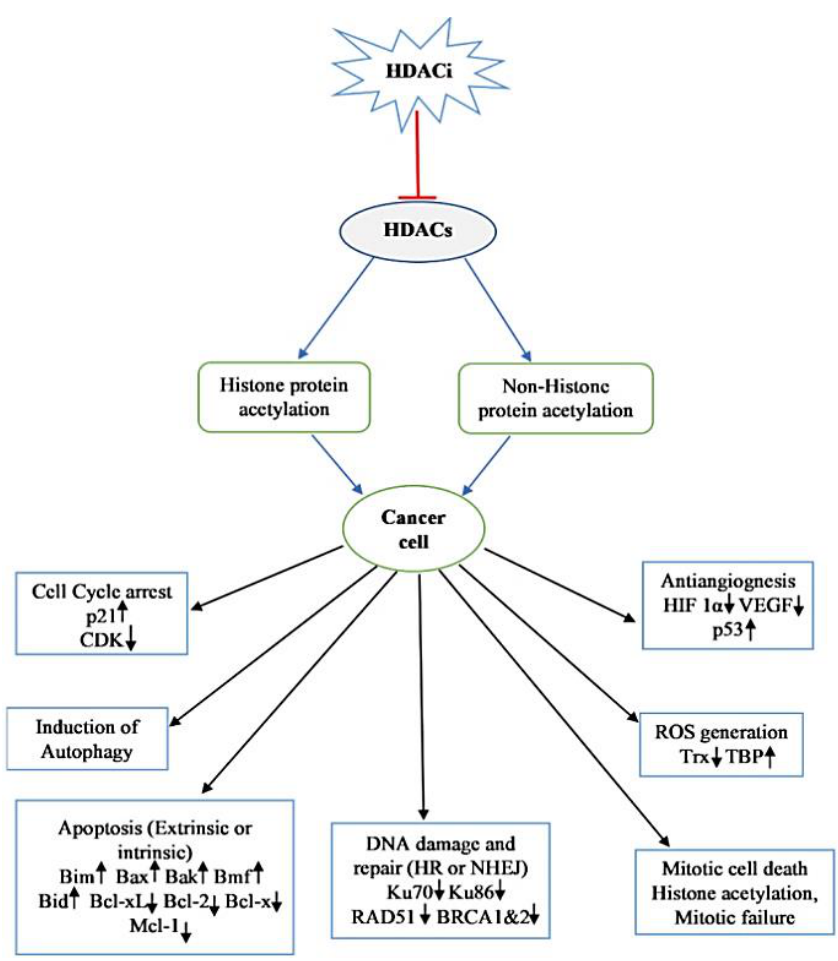
Figure 3. Multiple anti-tumor pathways such as, cell cycle arrest, induction of autophagy and apoptosis, DNA damage repair, ROS generation, angiogenesis inhibitor and mitotic cell death are activated by the action of HDACi in cancer cells. Arrows ( ↑ and ↓ ) indicates the increase and decrease, respectively, in the obtained variables. HIF, Hypoxia inducing factor; VEGF, Vascular endothelial growth factor; HR, homologous recombination; NHEJ, Non-homologous end joining; Trx, Thioredoxin; TBP, Thioredoxin binding protein.